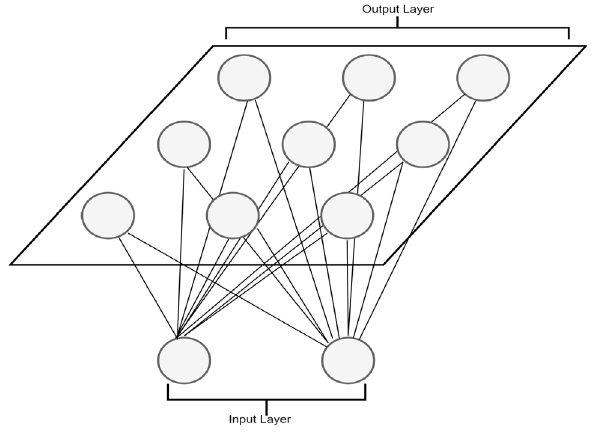
Fig. 6 SOM. Source : [8]